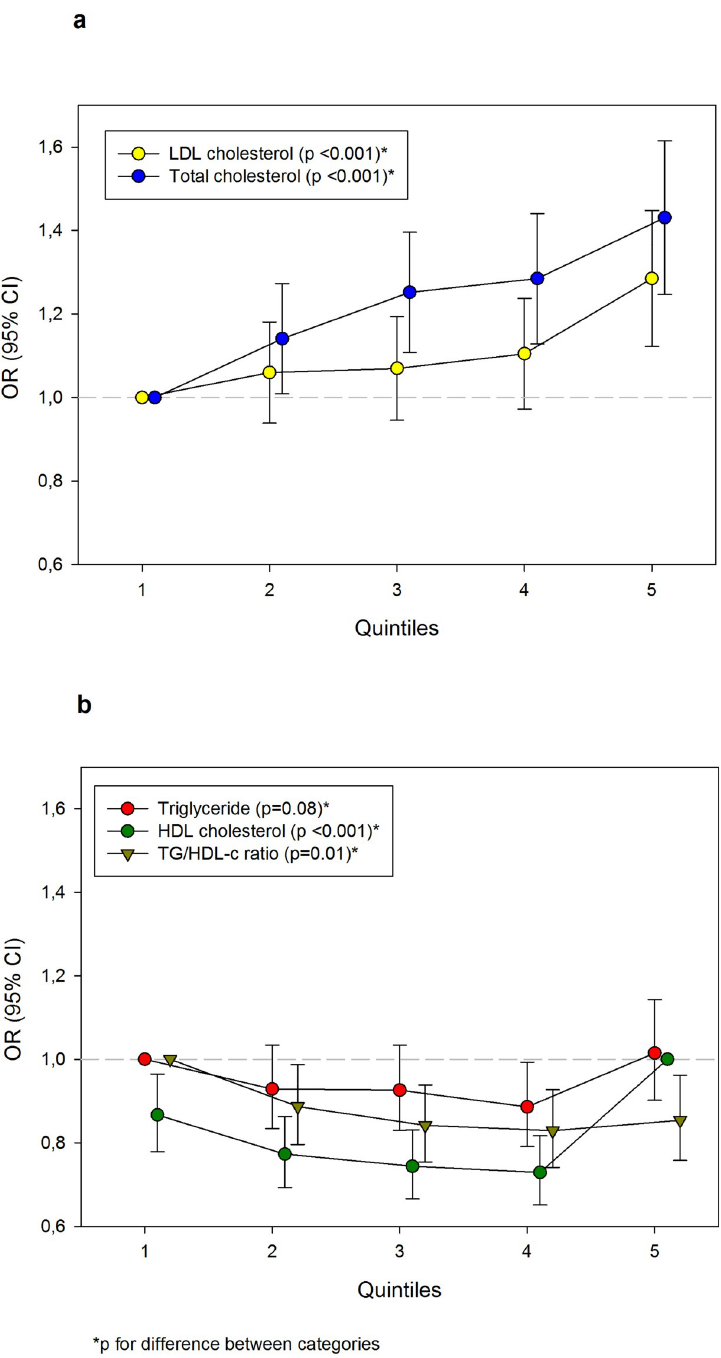
Fig 2. Adjusted odds ratios (ORs) with 95% confidence interval (CI) for one lifetime pregnancy by lipid quintiles in 32 618 women ( � 69 years of age) examined in Cohort of Norway during 1994–2003. All estimates were adjusted for age at examination, year of the first birth, body mass index (linear term), oral contraceptive use, smoking and educational level. a) Low-density lipoprotein (LDL) and total cholesterol, b) Triglyceride (TG), high-density lipoprotein (HDL) cholesterol and TG/HDL cholesterol ratio.